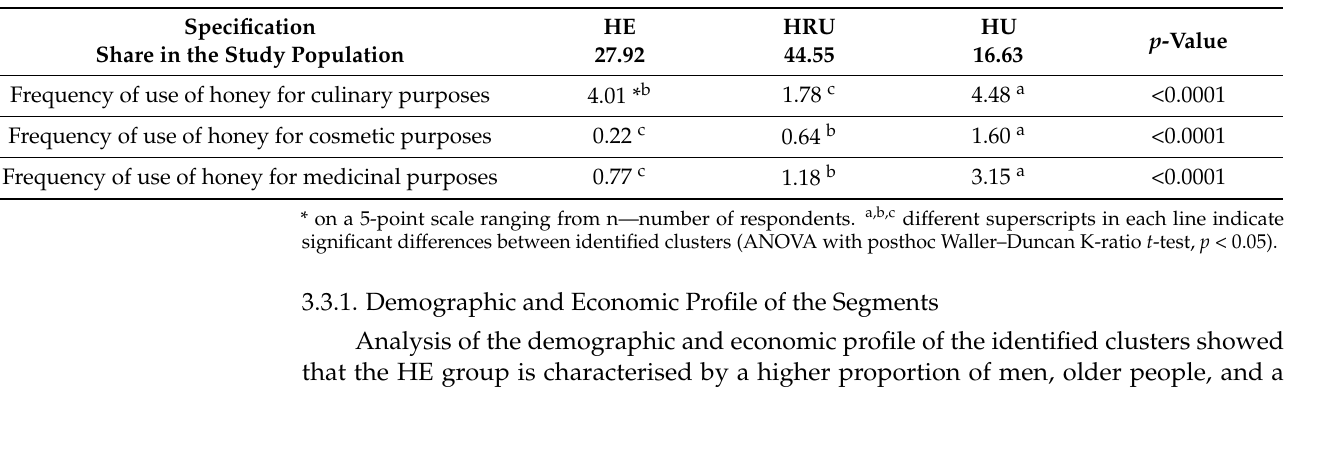
Table 2. Results of cluster analysis based on the frequency of honey use for culinary, cosmetic, and medicinal purposes (n = 487, data in